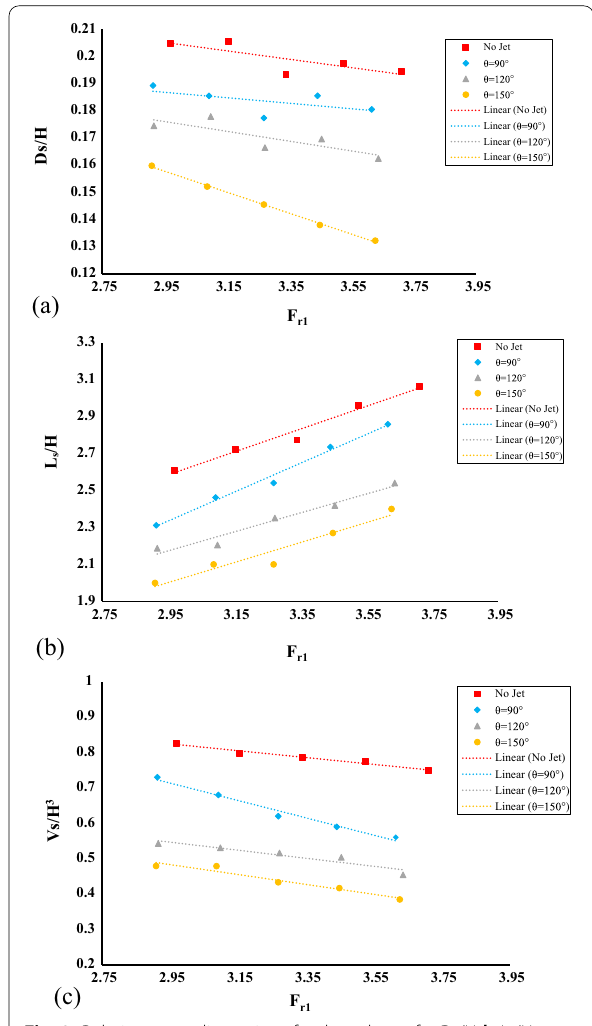
Fig. 3 Relative scour dimensions for the values of a D s /H ; b L s /H ; and c V s /H 3 versus F r 1 for the tested flow jet arrangements at gate opening G 6 =